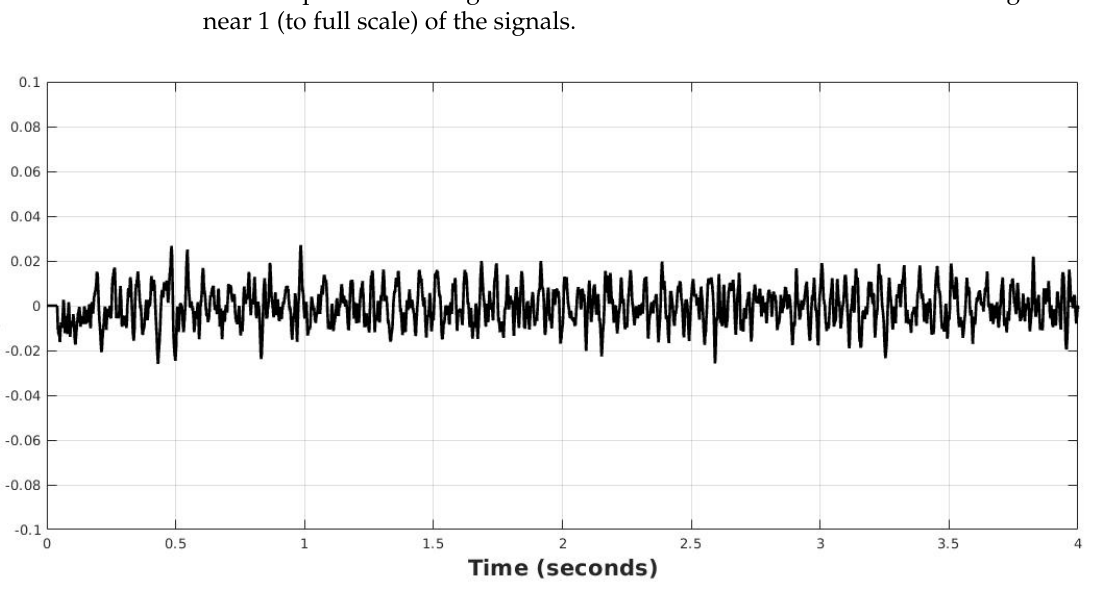
Figure 3. Recording of the sound card without signal.